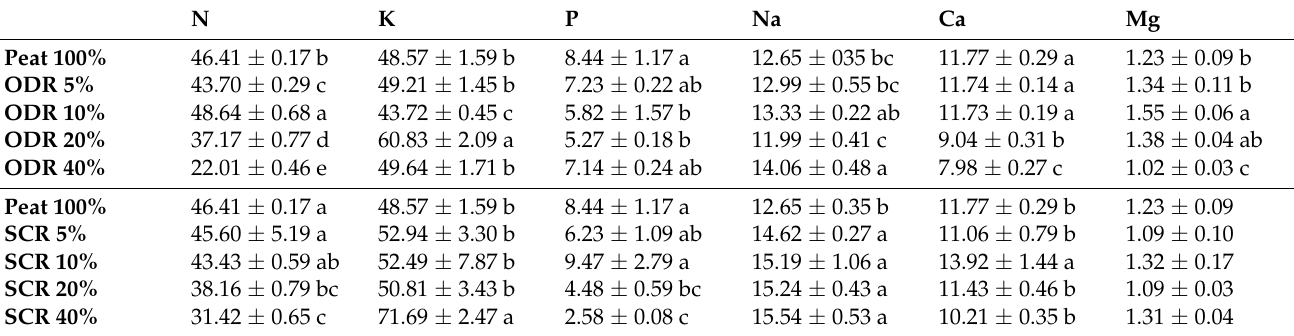
Table 5. Effects of growing media (Peat, O. dubium residue—ODR, S. cypria residue—SCR) on mineral element contents (mg/g dry weight) in sowthistle plants grown in the